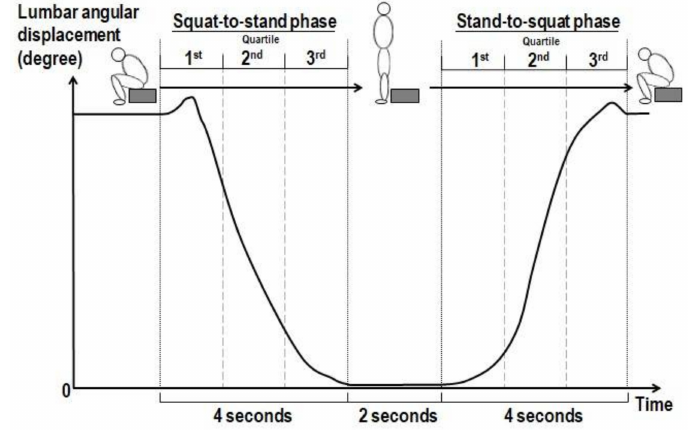
Figure 3. Procedures of execution of squat-to-stand and stand-to-squat tasks (performed before and immediately after deep